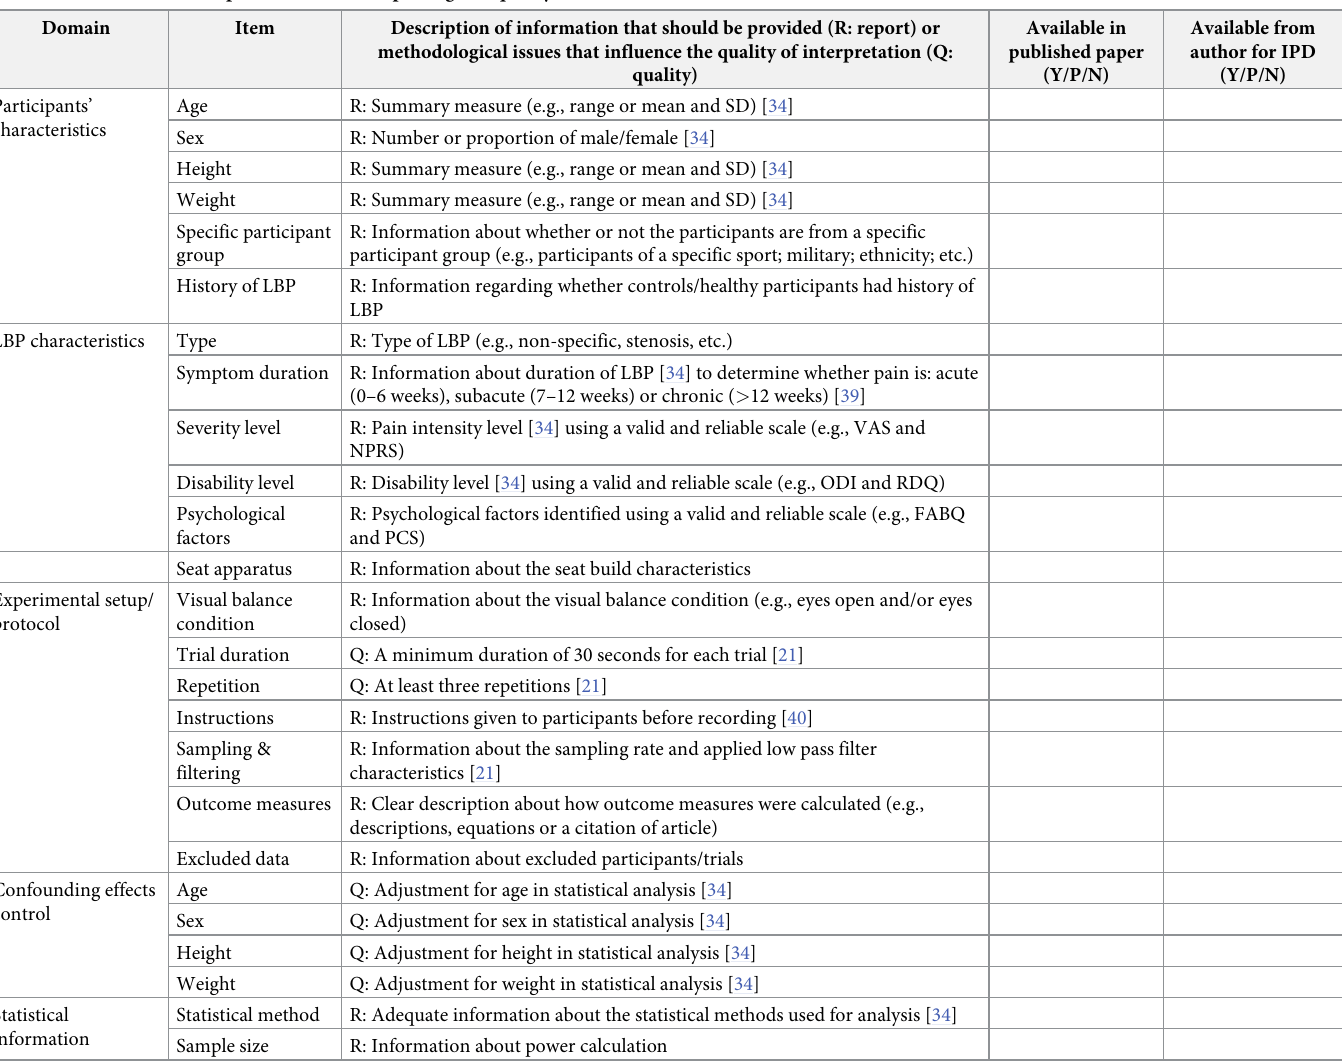
Table 3. A checklist for comprehensiveness of reporting and quality of the methods.